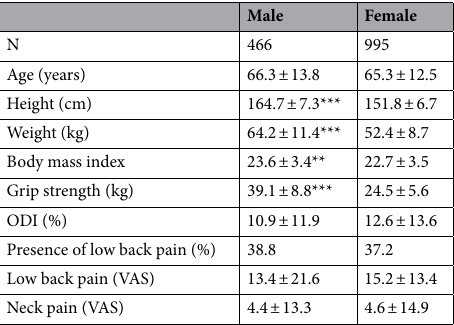
Table 1. Characteristics of male and female participants. The data are shown as the mean ± standard deviation. * p < 0.05, ** p < 0.01, *** p < 0.001: Significantly different from the values for female (Student’s t -test). ODI, Oswestry Disability Index; VAS, visual analog scale.